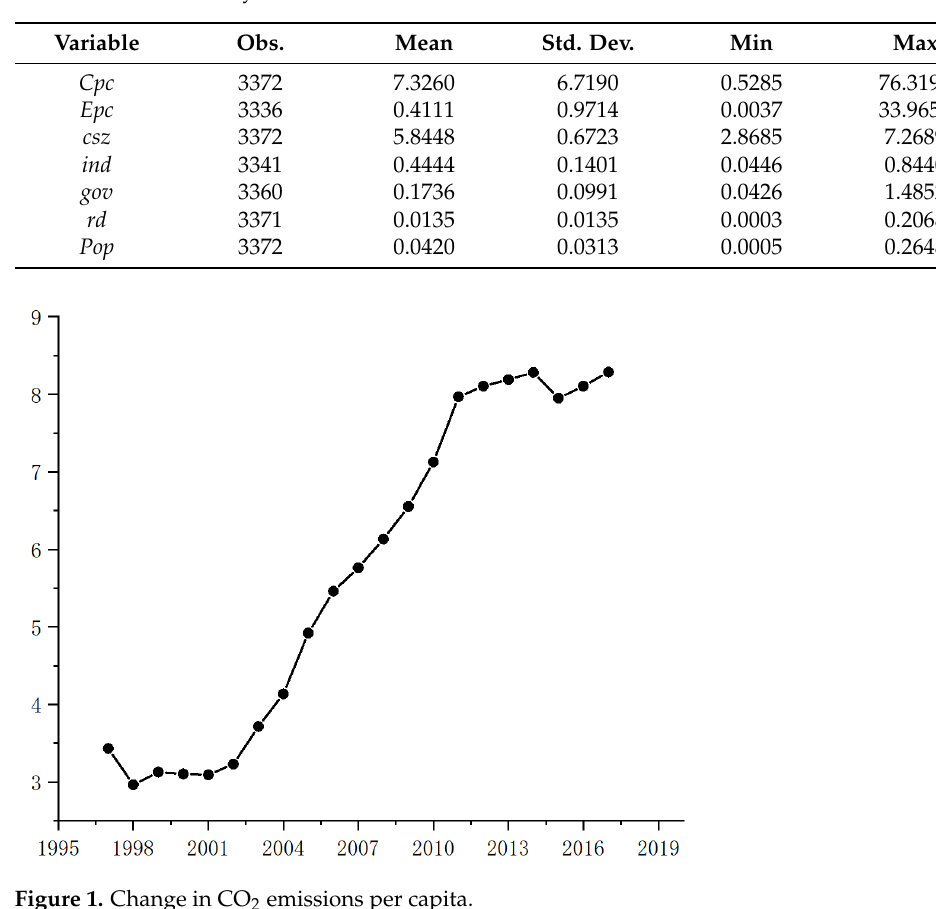
Figure 1. Change in CO 2 emissions per capita.